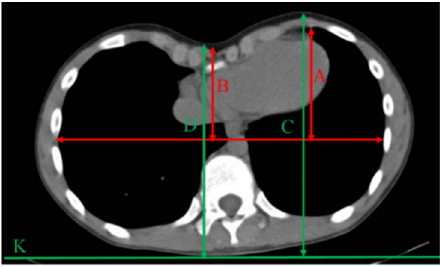
Figure 5. The correction index 3D (CI3D).